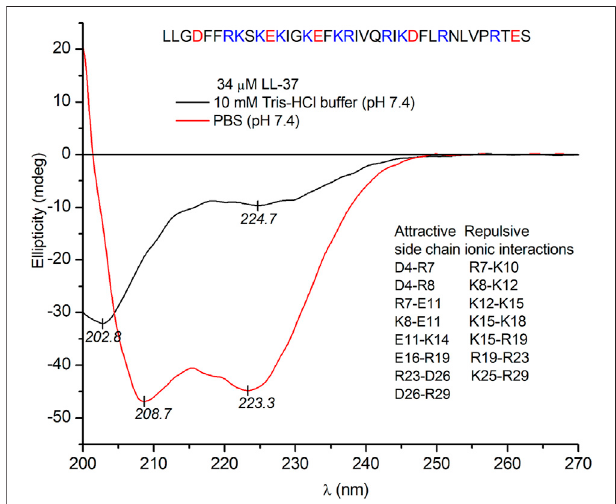
FIGURE3| Far-UVCDspectraof34 μ MLL-37recordedinPBSandina salt-free Tris-HCl buffer solution (the optical path length is 0.2 cm). PBS contains 137 mM NaCl and 2.7 mM KCl. The sequence of the peptide and helix promoting attractive and destabilizing repulsive electrostatic side chain interactions are shown (see